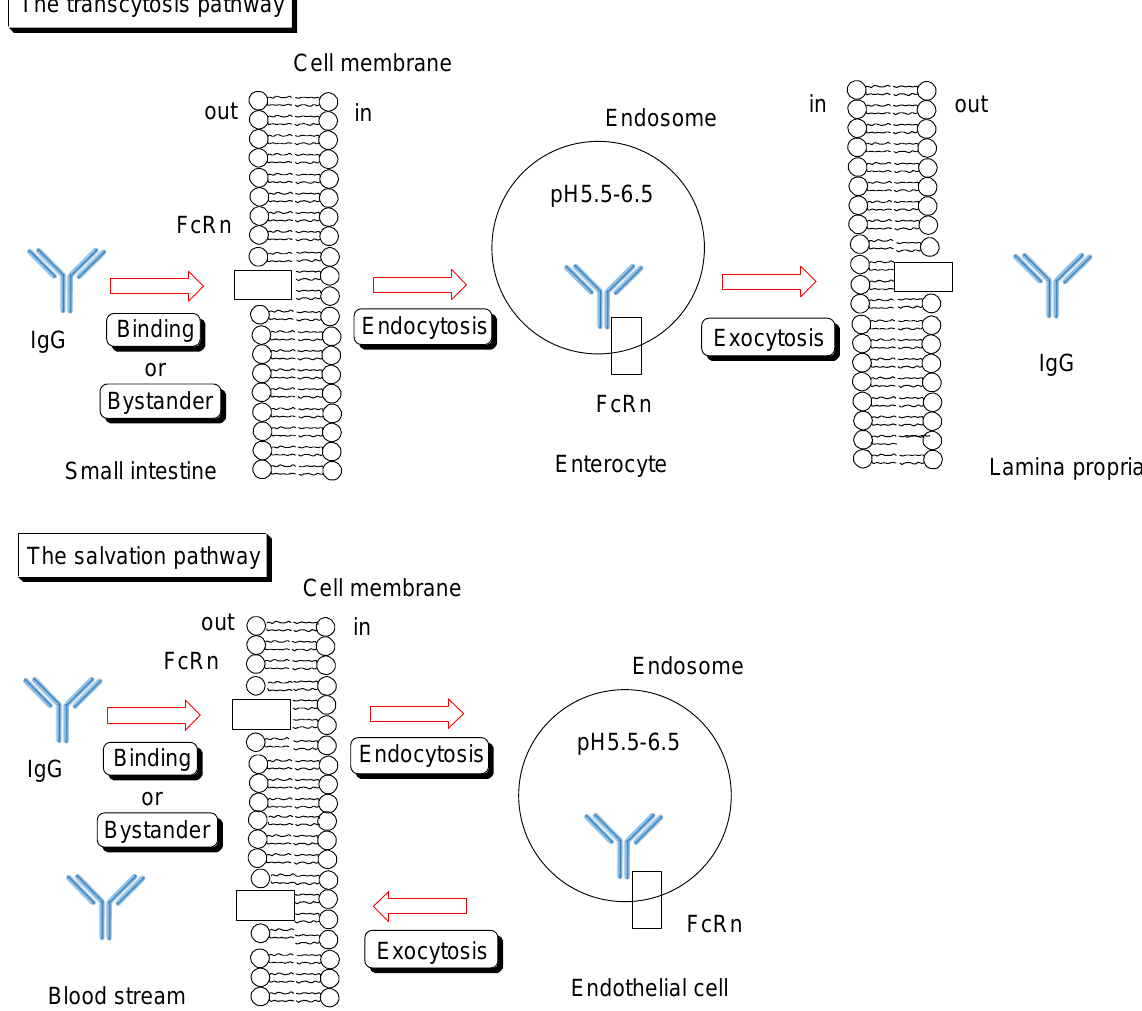
Figure 5. Schematic overview of transcytosis or salvation pathway of IgG through FcRn binding. 2.6.3. IgG Transepithelium through RMT Based on Translational Substance Exchange Under extracellular physiological pH, IgG antibodies do not bind tightly to